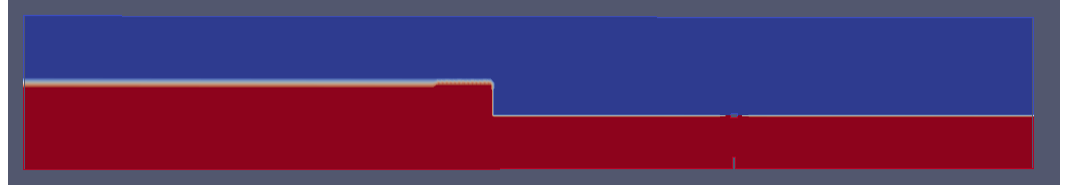
Figure 3. For the dam-break approach, the simulation domain is elongated and a water volume is placed on top of the initially still water